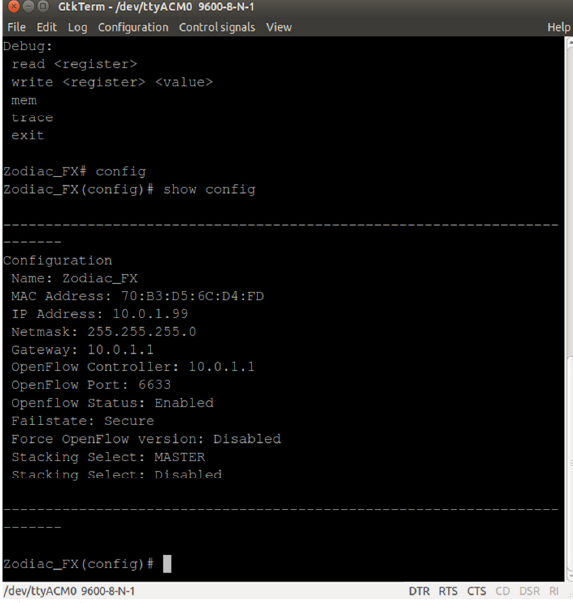
Figure 8. Zodiac FX configuration